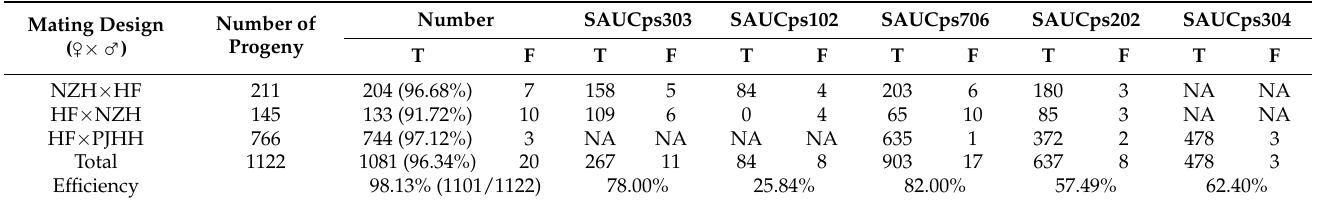
Table 2. Identification of true hybrids and foreign origins of 1122 F 1 individuals using five SSR markers.